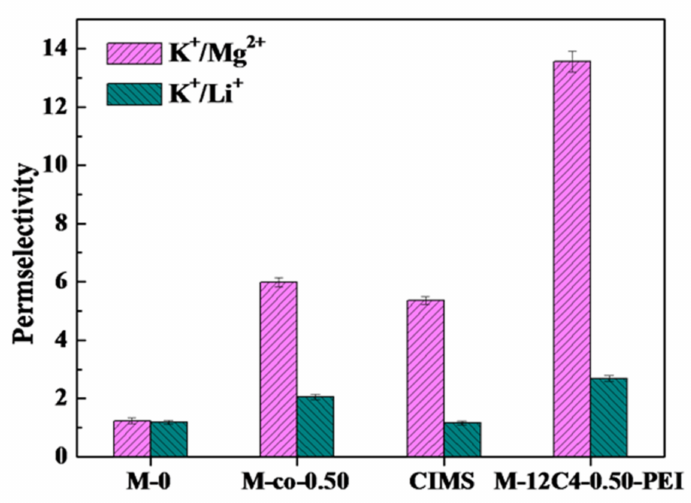
Figure 10. Permselectivity for membranes M-0, M-12C4-0.50-PEI, M-co-0.50 and CIMS in 0.05 M binary mixture of KCl/MgCl 2 and KCl/LiCl at current density of 5.0 mA · cm − 2